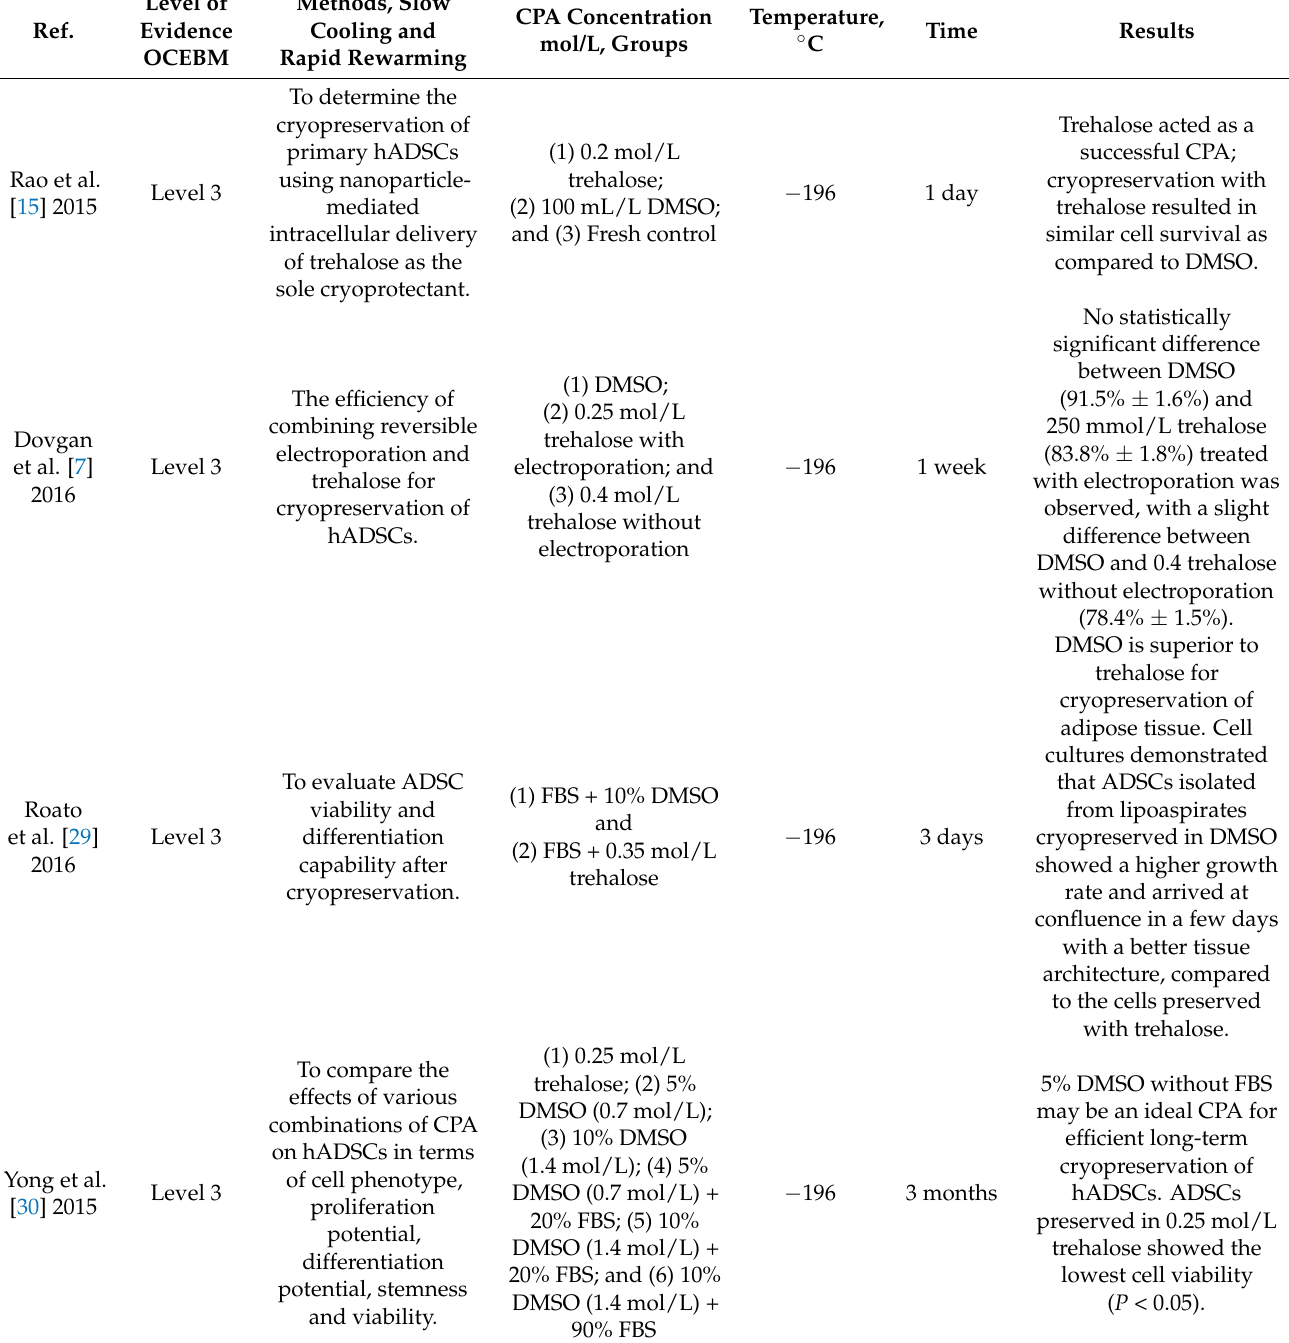
Table 2. Cryopreservation with trehalose vs. dimethyl